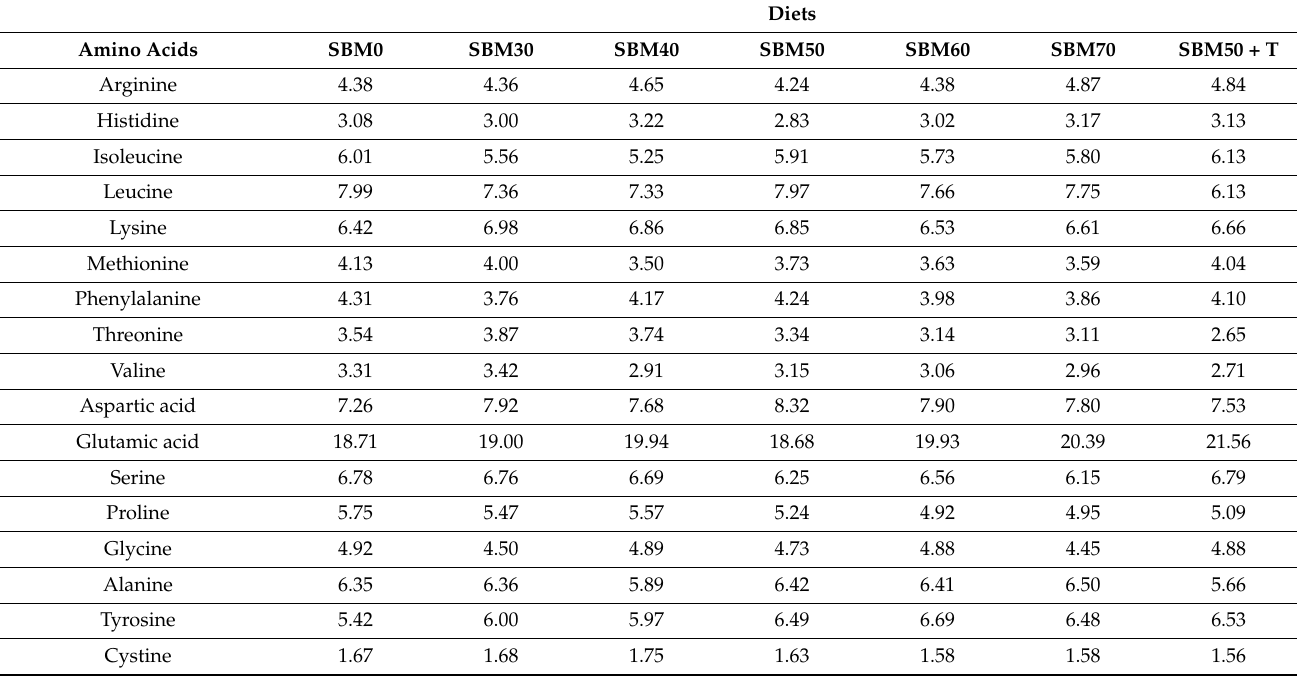
Table 2. Amino acid composition (% total amino acid) of the test diets.